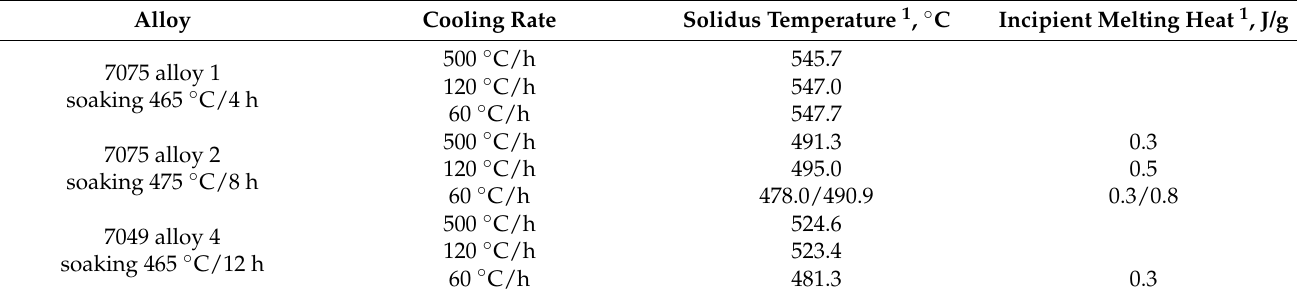
Table 4. DSC tests results of alloys 1, 2, and 4 after homogenization with differentiated cooling.